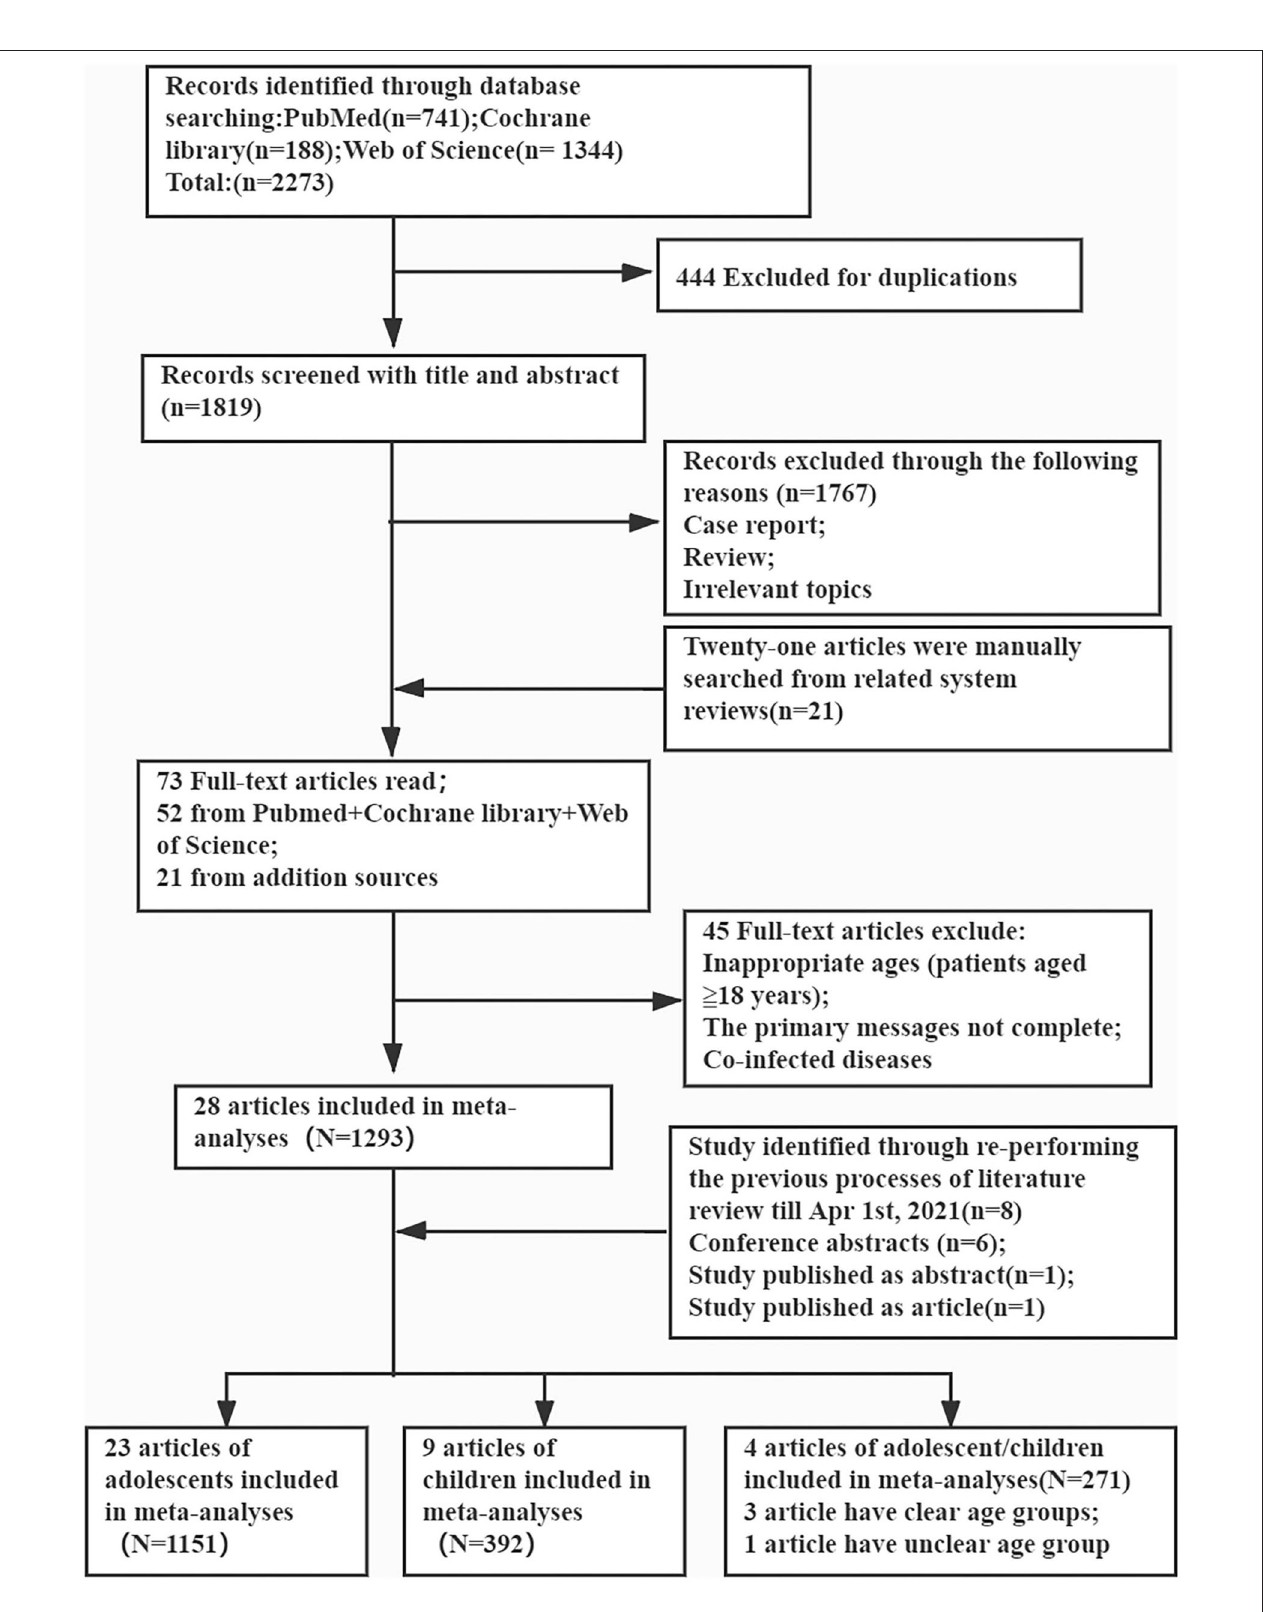
FIGURE 1 | Preferred reporting items for the review flow diagram for identification of relevant studies.